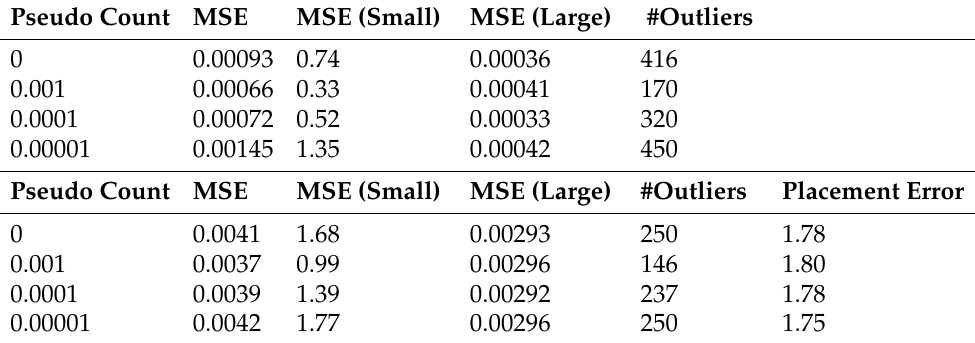
Table A1. Impact of adding pseudo counts to terminal branch. MSE: MSE of full distance matrix; MSE (small): MSE for the smallest five distances for each species; MSE (large): MSE for all the distances except the small distances; upper: results for backbone species; bottom: results for query species.